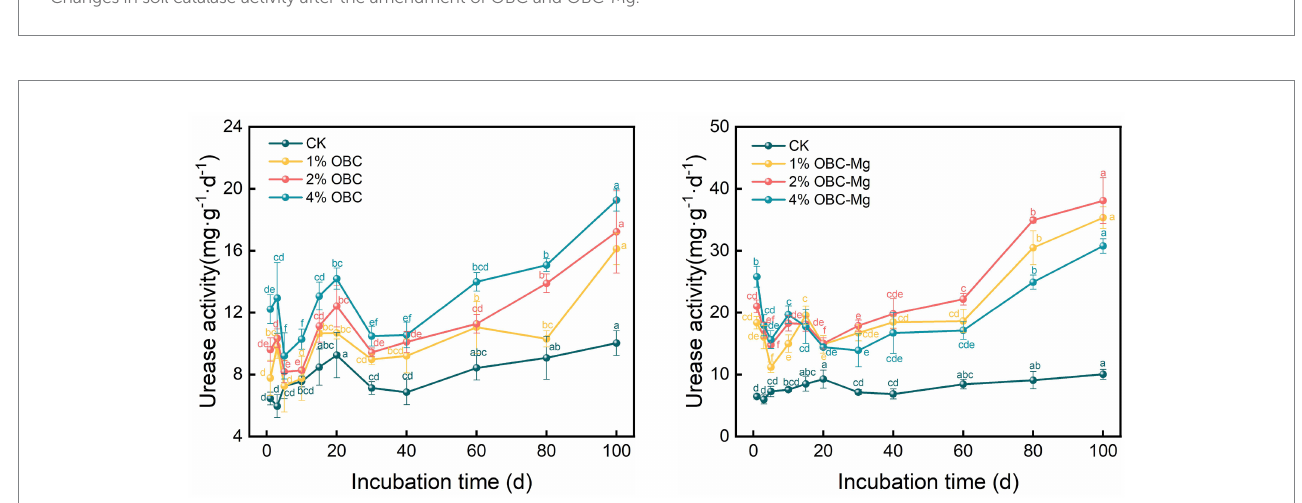
FIGURE 13 Changes in soil urease activity after the amendment of OBC and